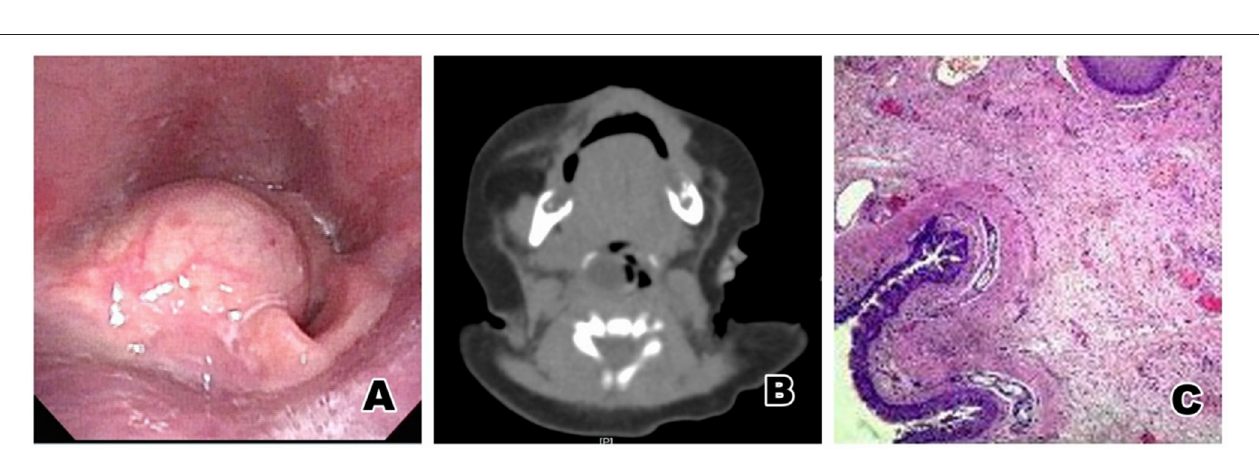
FIGURE 1 | (A) Electronic nasopharyngoscopy before operation: A cystic mass of about 2.0 × 2.5 × 1.0cm with a smooth surface can be seen on the right eustachian cushion in the nasopharynx, extending from the posterior margin of the soft palate to the oropharynx and midline. (B) Nasopharynx CT: This image shows a mass-like soft tissue density shadow from the right nasopharyngeal wall to the oropharyngeal wall, the adjacent airway being compressed and narrowed. (C) Pathological results: The cyst cavity was lined with squamous epithelium and pseudostratified ciliated columnar epithelium, and smooth muscle and lymphocyte infiltration were seen under the epithelium. The diagnosis was a bronchogenic cyst of the nasopharynx.